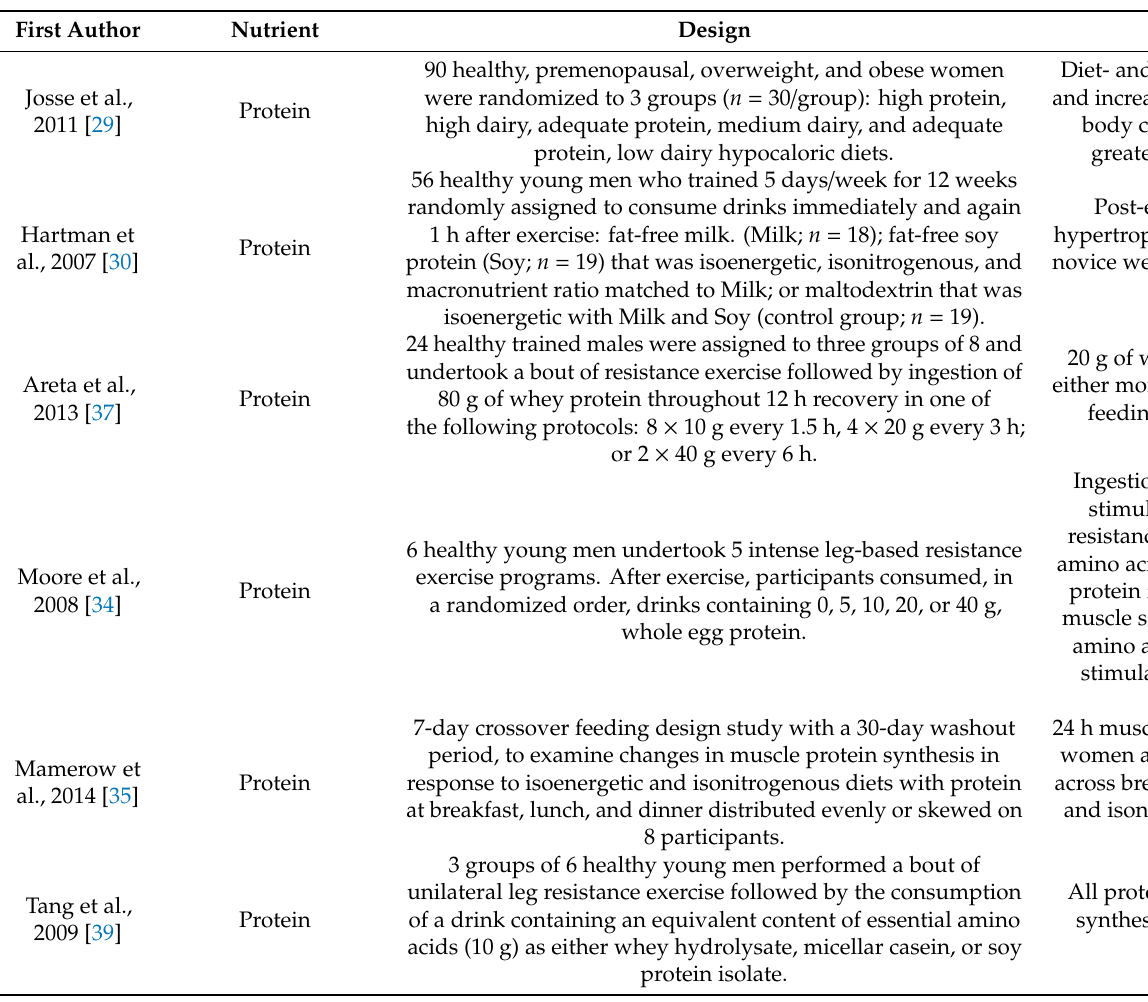
Table 1. Primary studies on the role of macronutrients on